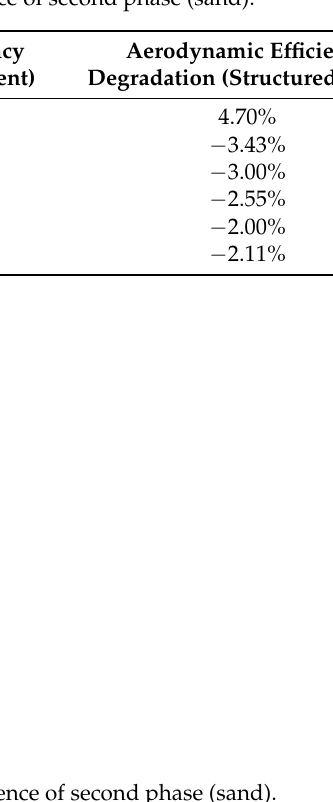
Figure 18. L/D percentage degradation due to the existence of second phase